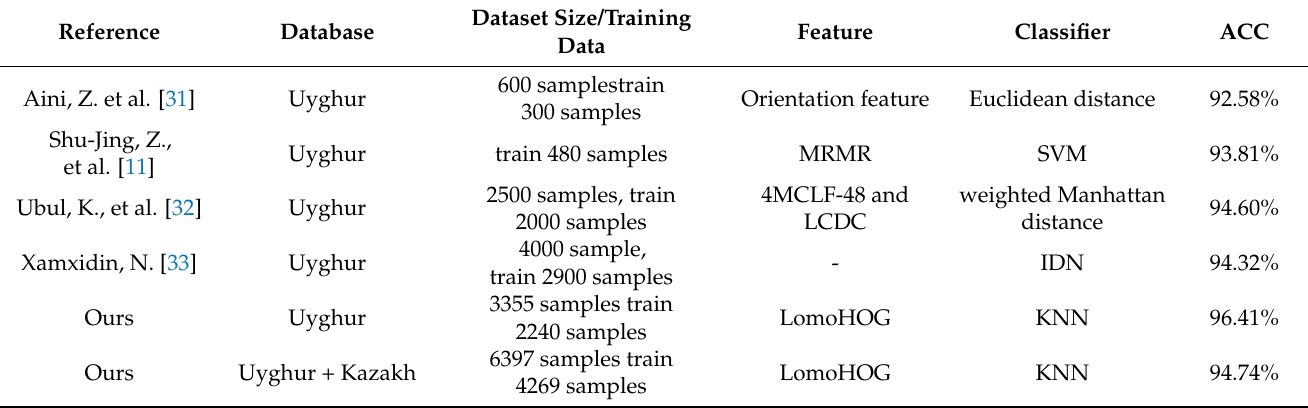
Table 10. Results of Uyghur datasets and comparative experiments.